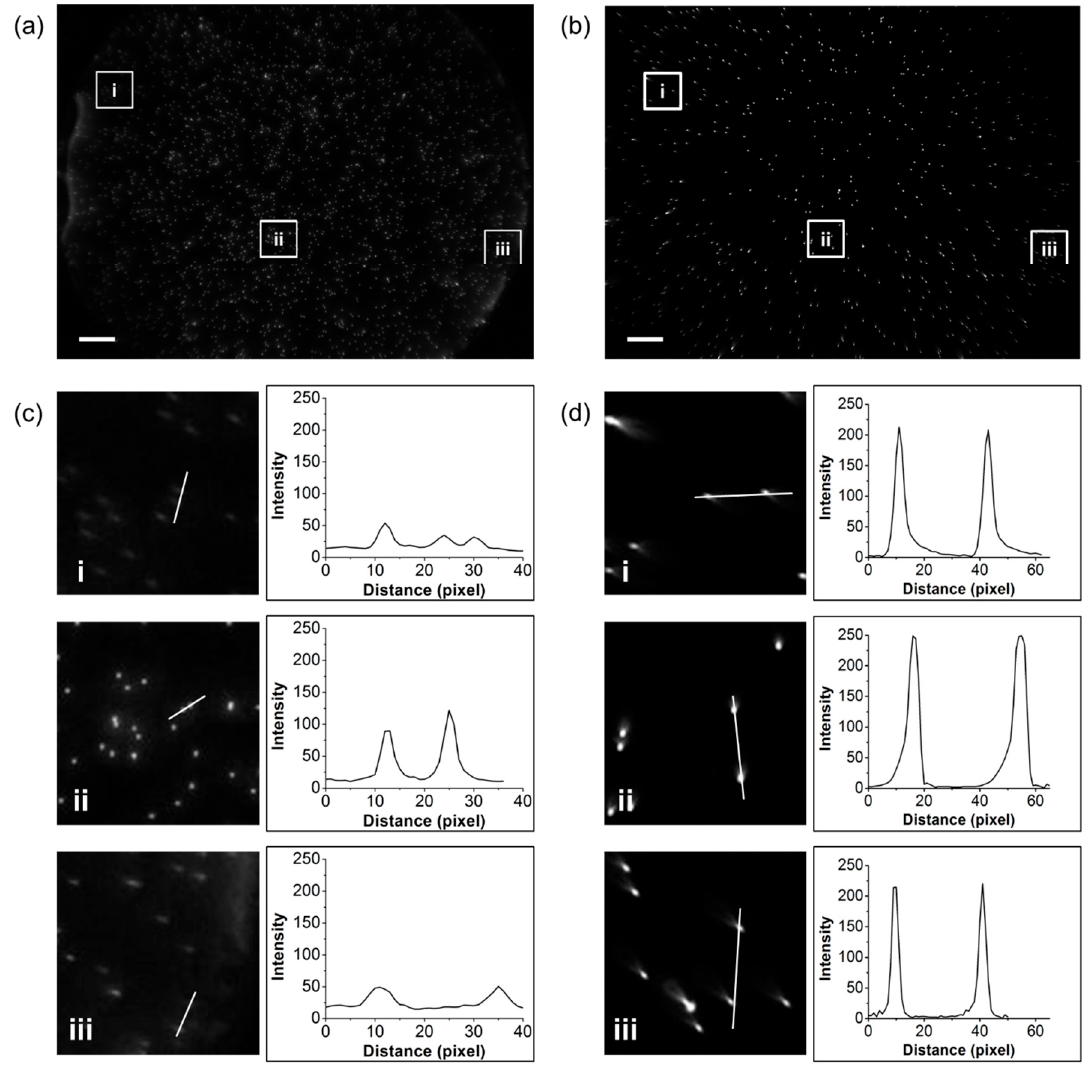
Figure 7. Imaging performance of single-lens fluorescence microscopy with curved sample chamber. Fluorescence images taken for beads of diameter 10 µm for: ( a ) planar; and ( b ) curved sample chambers. The fluorescent microbeads are distributed uniformly over the entire FOV. The intensity profiles of the bead images are shown in ( c , d ). As observed for the curved substrate, a wider area of the bead image is more focused in ( b ), and the aberration is lower than that in ( a ). (Scale bar = 1 mm).